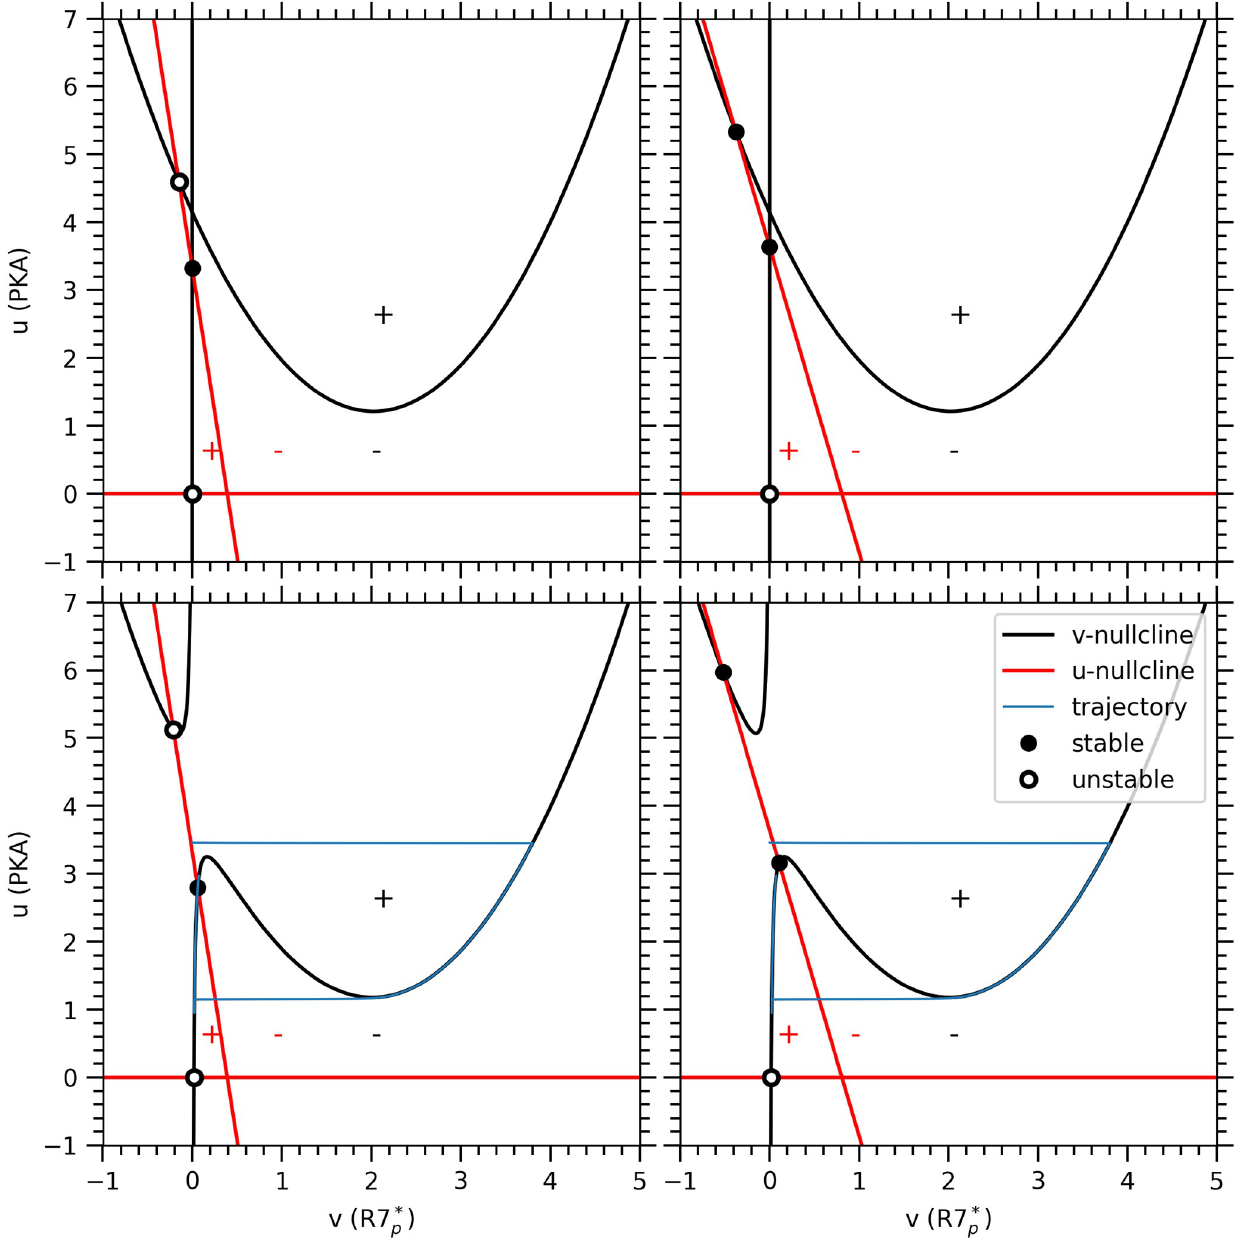
Fig 4. U and V nullclines for different parameters. Using the x -nullcline x = v in (Eq 8), we obtain a pair of nullclines for both variables u and v shown for the same parameters as in (Fig 3) except for β and τ 3 , which are chosen to correspond to different ISIs (see Table 2): Top panels from left to right are for ISI = 200msec, 400msec with I = 0 μM . Bottom panels from left to right are the same but with I = 0.1 μM . These panels also include the projection of the trajectories from the location of the stable fixed point without stimulus ( I = 0 μM ) to the new one ( I = 0.1 μM ). The time it takes to get from one to the other corresponds to the ISI duration. Closed circles represent stable fixed points, while open circles represent unstable/saddle fixed points. +/ − signs represent the signs of du / dt and dv / dt , which change across u and v -nullclines, respectively.